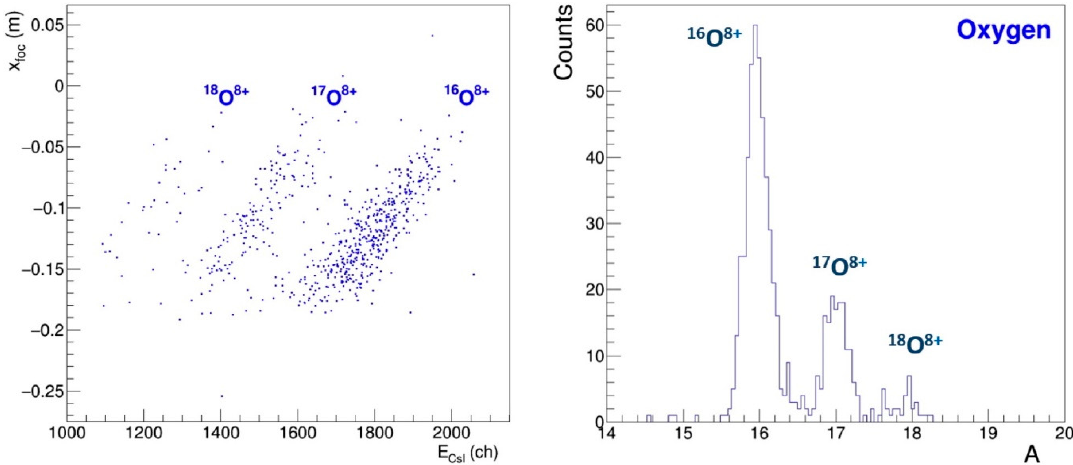
Figure 27. Energy spectrum of a 22 Na radioactive source obtained with a LaBr scintillator of the GDA detector. The peaks at 511 keV ( β + annihilation) and 1274 keV (direct gamma decay) respectively around channel 830 and 1840, are clearly visible, with FWHM resolution of 4% and 2%, respectively. With such a resolution, a few energy acceptance windows can be set on the online data, and simulations have shown that the amount of data produced by the GDA will decrease to less than 10 4 cps per detector, which is a reasonable counting rate that can be handled by the data storage system.